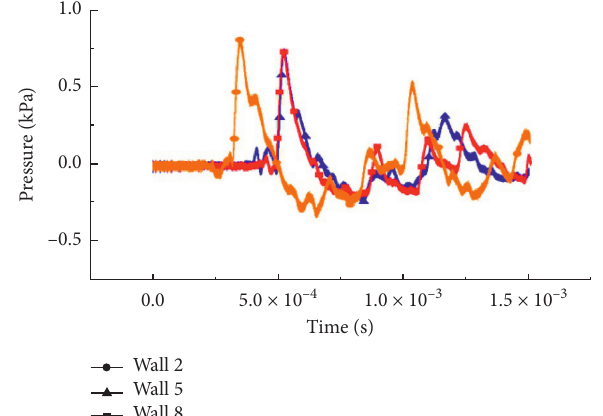
Figure 5: Comparison of overpressure–time curves of Walls 2, 5, and 8.